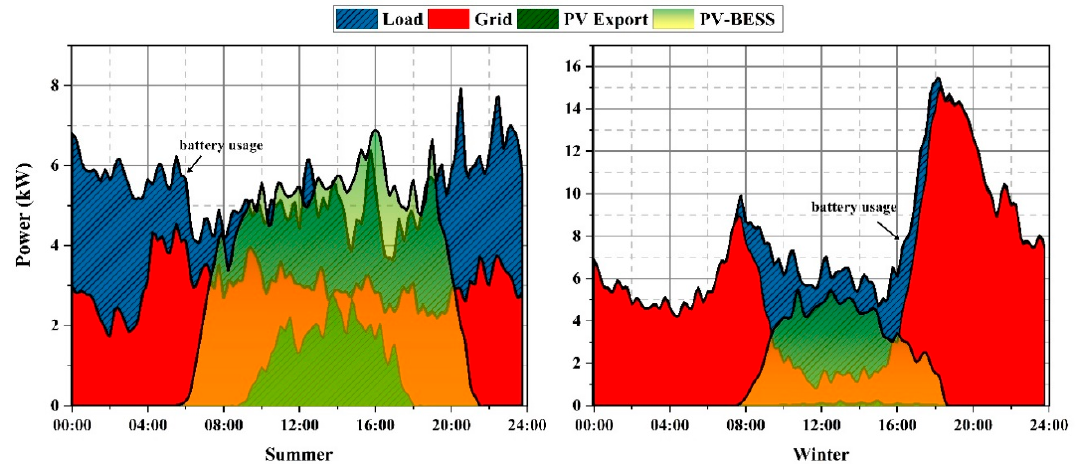
Figure 6. Seasonal load profile for SHAC.